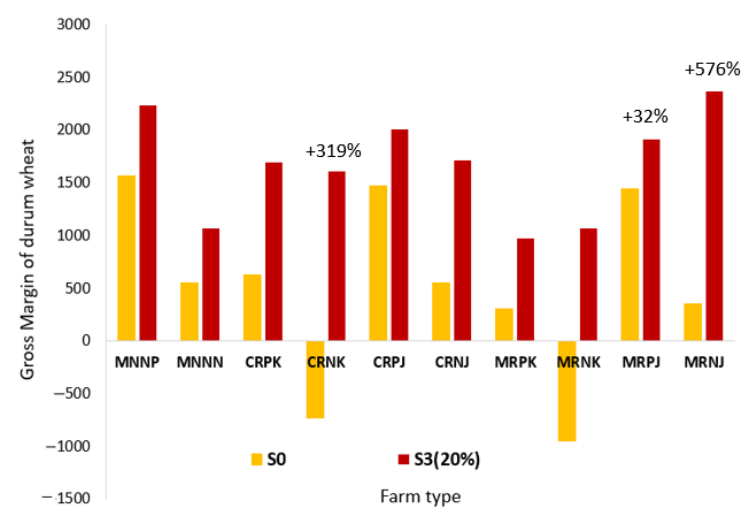
Figure 7. Gross margin difference between S0 and S3